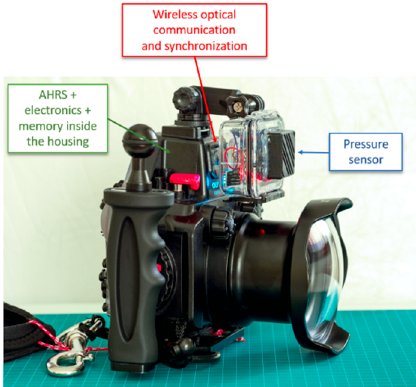
Figure 17. A prototype underwater device developed by some of the authors allowing the recording inertial and pressure measurements synchronized with image of inertial and pressure measurements synchronized with image shots.